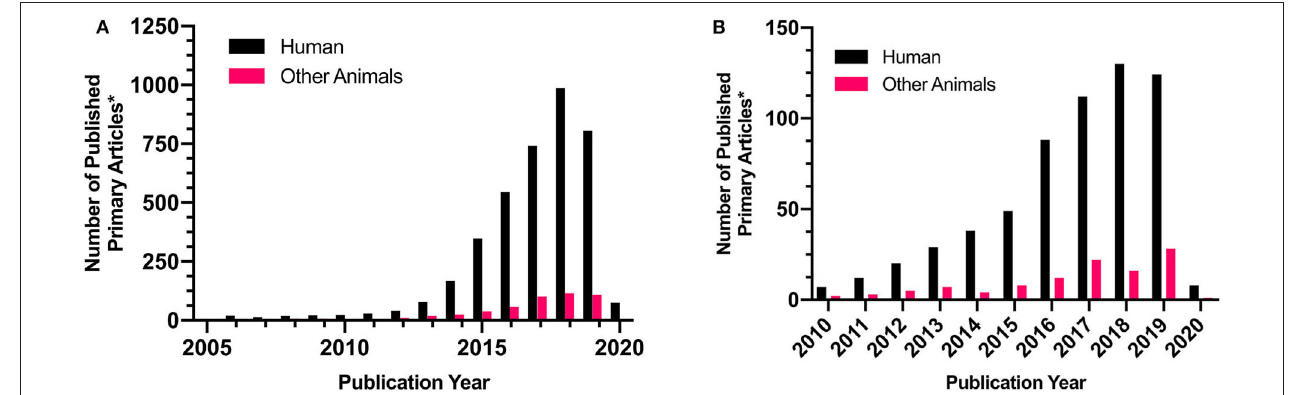
FIGURE 4 | Representative comparison of human and veterinary research articles in the involving “3D Printing” or “bioprinting.” Demonstrates the incidence of primary research on (A) 3D printing or (B) bioprinting in human and veterinary research Comparison Research article counts were generated via pubmed targeted searches. Searches were conducted on 6/24/2020 with the following keywords: (A) “Human + 3D Print” and “Other Animals + 3D Print”, duplicated and review articles were excluded, and the following species were included into the yearly counts: “Canine,” “Bovine,” “Equine,” “Rabbit,” “Goat,” “Porcine.” This was repeated following the initial searches: (B) “Human + bioprint” and “Other Animals + bioprint” with the same exclusion criteria. This is not an exhaustive literature search but is believed to be representative of trends in scientific